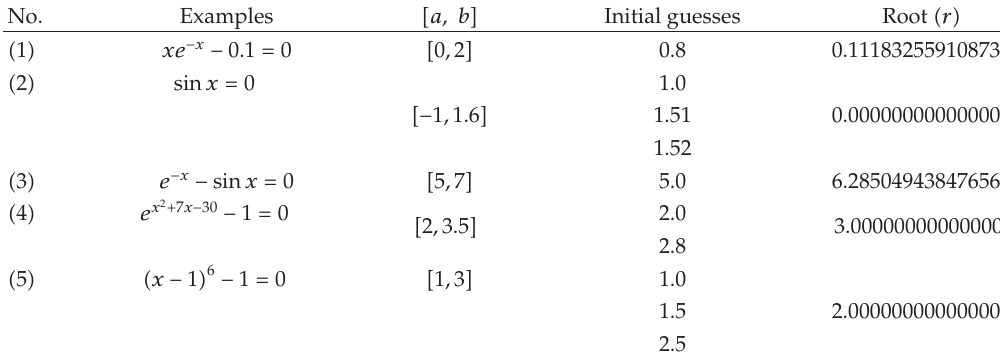
Table 1: Test problem (cid:5) nonlinear equations (cid:6) .